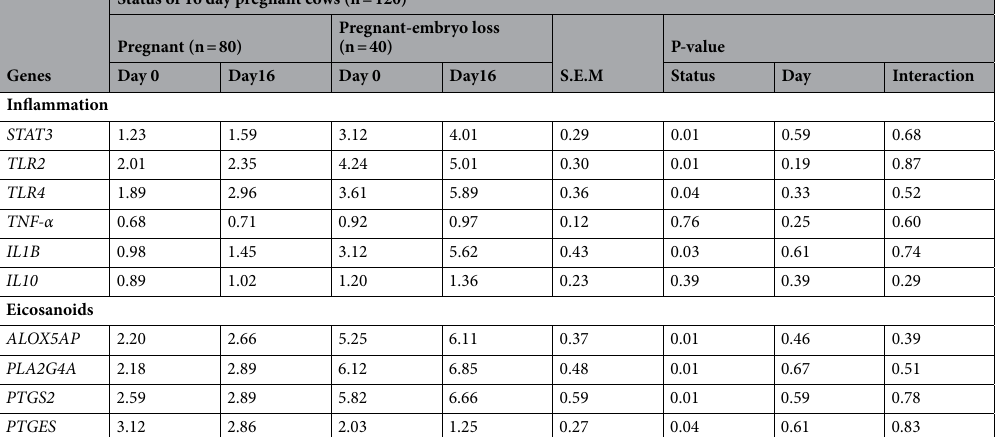
0 and 16 were not different between pregnant cows (n = 80) or pregnant cows that lost embryos (n = 40). Perhaps this is associated with differential expression of the various leucocytic cell types in blood. Damage induced by ROS can occur through modulation of cytokine expression and pro-inflammatory substrates via activation of redox-sensitive transcription factors AP-1 and p53 30 . The increase in IL1B expression is relevant, since the pro-inflammatory cytokines ( IL1B and TNF-α ) activate the apoptotic cascade, causing cell death (Agarwal et al. 2012). The amplified gene expressions of leucocytes in pregnant cows losing embryos were inherent when cows were sampled at both TAI (Day 0) and Day 16. This may be emblematic of an inherent increase in the cow’s overall oxidation status contributing to a detrimental dialogue between developing embryo and oviductal/endometrial tissues. Overall enzymatic and nonenzymatic antioxidant responses in blood were low for a sustained period from days 0 to 60 days in non-pregnant or preg- nant cows experiencing embryo loss. Overall pregnancy loss from TAI to day 60 was 65%. Within the leucocyte series of blood cells, the two pre- dominant cell types are neutrophils and lymphocytes. After pathogen detection, toll-like receptors (TLR2 and TLR4) 31 , activate signaling pathways (e.g., STAT3 and NF-κB), which result in production of pro-inflammatory cytokines 32 such as IL1B in the present experiment. The TLR2 is expressed most abundantly in blood leucocytes and mediates host response to Gram-positive bacteria. The TLR4 gene is a member of the toll-like receptor fam- ily, which plays a fundamental role in pathogen recognition and activation of innate immunity. Macrophages that produce IL1B aid the predominate population of lymphocytes to fight infections reflecting an integration of other local cell types to produce inflammatory mediators. In contrast, IL10 is a cytokine with potent anti- inflammatory properties and was not overly expressed supporting overall coordination of sustaining an inflam- matory environment in cows that experienced embryonic loss. Prolonged inflammation and its carryover effects impair immune status and reproductive performance of dairy cows 11,33 . Up-regulation of genes associated with the pro-inflammatory cascade ( TLR2, TLR4 and IL1B ) in peripheral blood of leucocytes in cows at 16 days after TAI was evident in cows with embryonic loss compared with pregnant cows. Pathogen elimination and tissue remodeling processes may be impaired in cows with embryonic loss. Neutrophil stimulation produces ROS and lysosomal enzymes as well as pro-inflammatory and anti-inflam- matory mediators, which include bioactive lipids such as eicosanoids: prostaglandins, leukotrienes and throm- boxanes. These are lipid-based cellular hormones that regulate hemodynamics, inflammatory responses, and other intracellular pathways. Furthermore, the endocannabinoid system also regulates inflammation and is altered in the endometrium of cows experiencing early embryonic loss. Such cows had increased mRNA expres- sions of CNR1 receptor and synthetic NAPEPLD and decreased mRNA expression of the hydrolyzing enzyme (FAAH) 34 . Results of present study also revealed increases in PBL mRNA expression of genes related to eicosanoid metabolism in healthy cows with embryonic loss compared with healthy pregnant cows at day 16. Increase PLA2G4A mRNA expression in cows with embryonic loss would contribute to an increase in the hydrolysis of cell membrane phospholipids to release arachidonic acid, which subsequently could be used for leukotriene synthesis since mRNA expression of ALOX5AP was increased. The expression of PBL PTGS2 mRNA was increased in pregnant cows with embryonic loss, but PTGES mRNA expression was increased in PBL of pregnant cows. Within the endometrium of day 15 cyclic cows, PGE 2